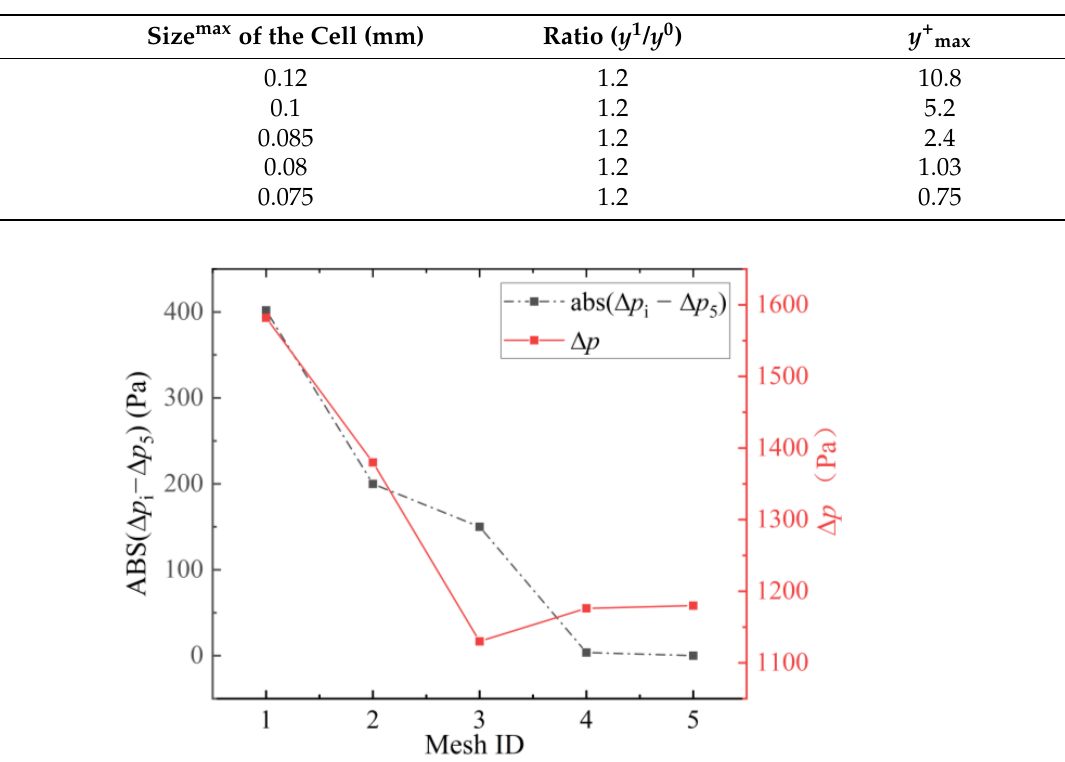
Table 2. The mesh independence test.